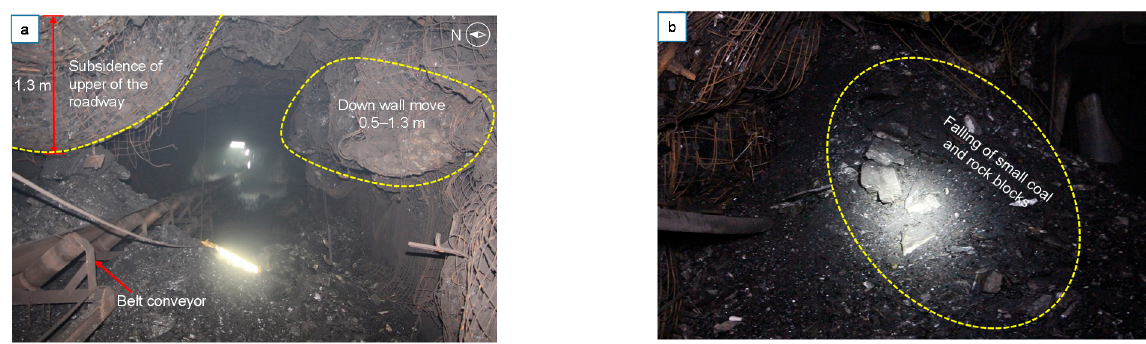
Figure 5. In situ record photos showing damage to the rockburst and high energy tremor in +450 horizontal No. B3 + 6 working face ( a ) rockburst “2 1”, ( b ) high energy tremor “3 21”.